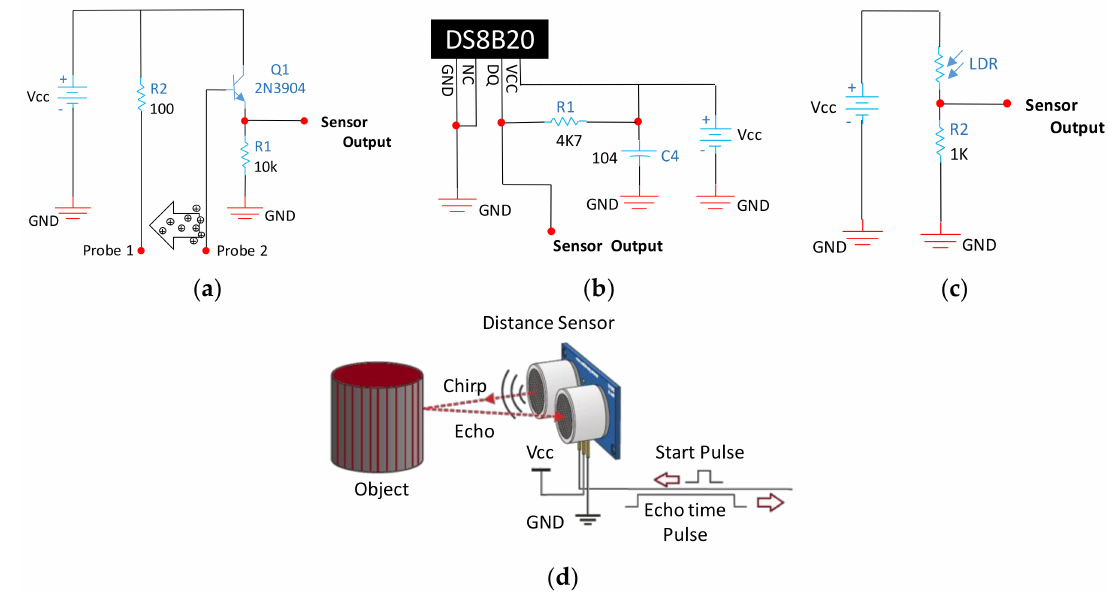
Figure 2. Electric circuits for the sensors used in our tests. ( a ) moisture soil sensor. ( b ) relative air humidity and temperature sensor. ( c ) light sensor. ( d ) distance